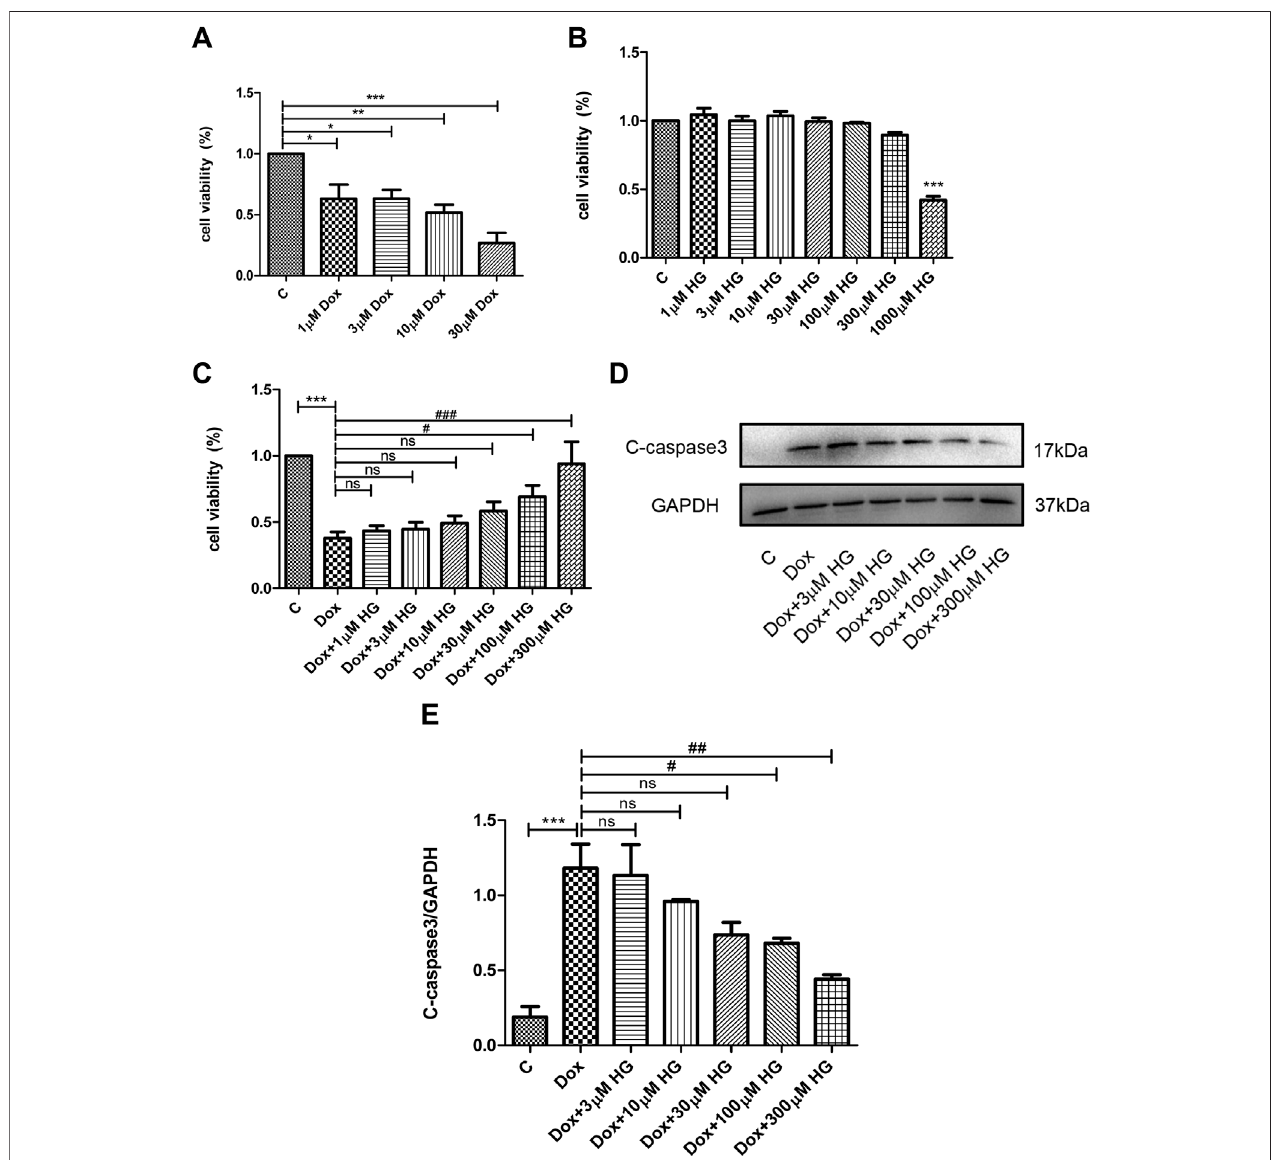
FIGURE 5 | HG inhibited DOX-induced NRVM apoptosis in vitro . (A) NRVMs were treated with DOX (1, 3, 10, and 30 μ M) for 24 h after detection by the CCK8 reagent. (B) NRVMsweretreatedwithHG(1,3,10,30,100,300,and1000 μ M)for24 hafterdetectionbytheCCK8reagent. (C)